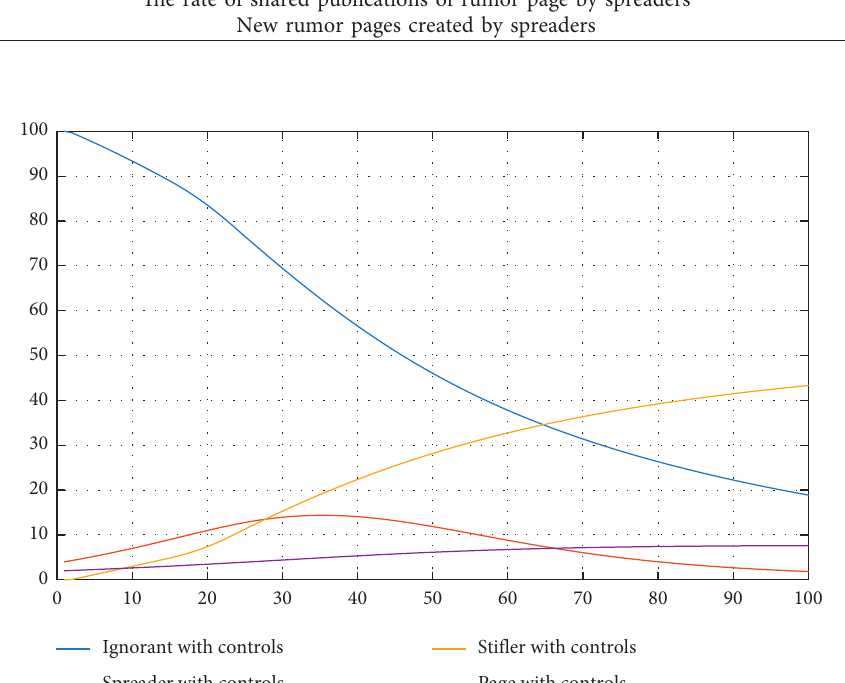
Figure 3: Dynamics with controls u , v , and w